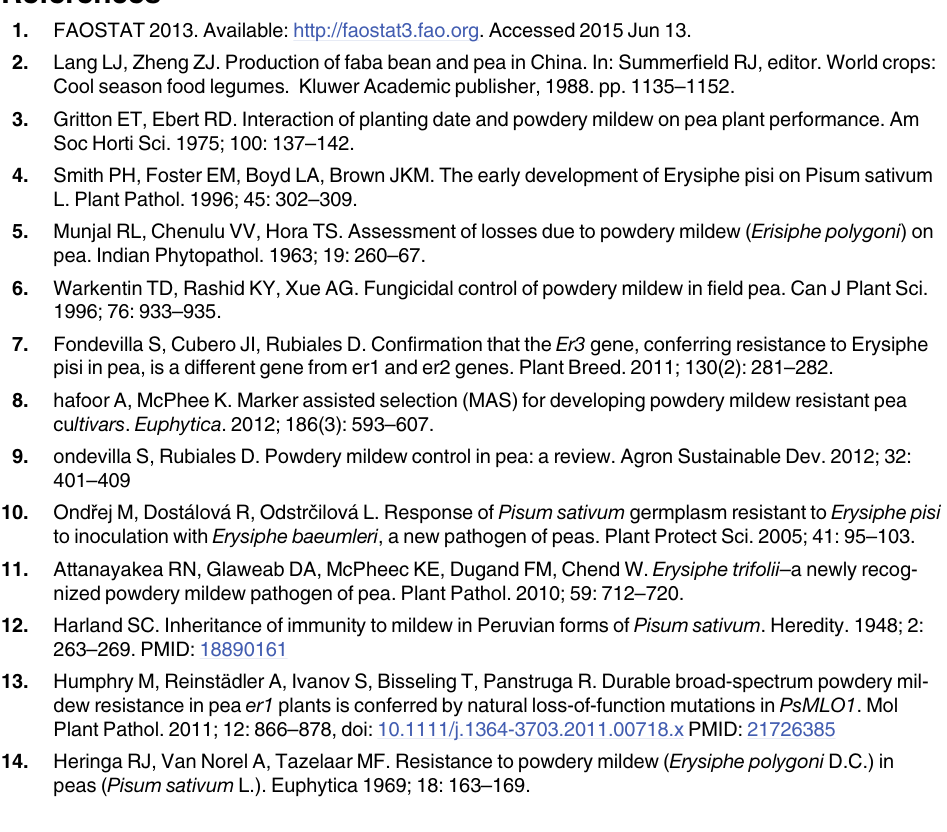
S1 Table. Information for the five developed primer pairs flanking the mutation site (1121) associated with the er1 -6